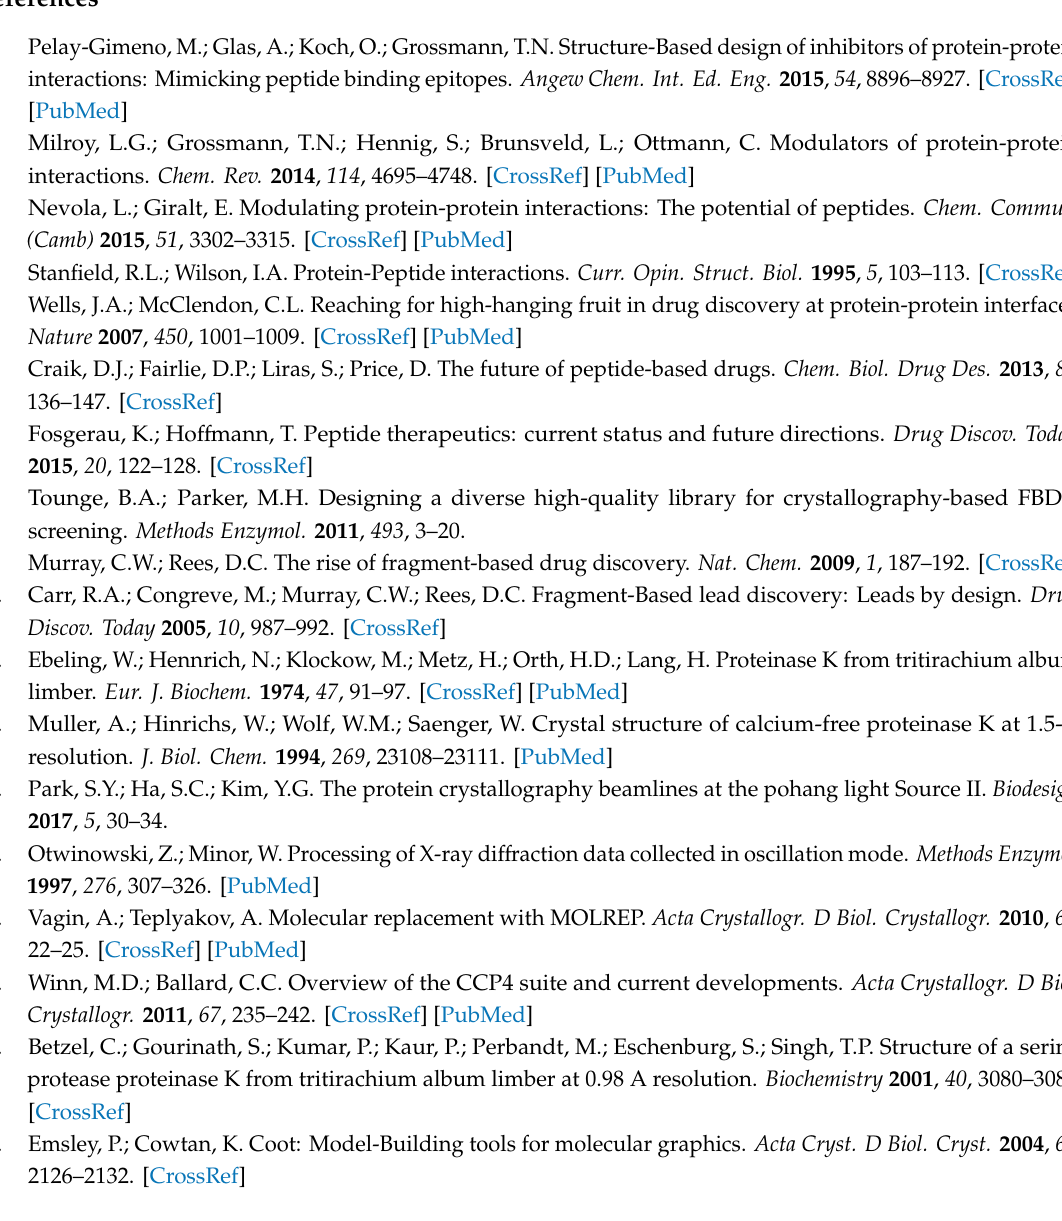
Figure S1: 2Fo-Fc electron density map (blue, counted 1.5 σ ) and Fo-Fc electron density map (green, counted 3 σ ; red, counted -3 σ ) of proteinase K complexd with triglycine (cyan). Figure S2: Comparison of substrate binding site of PaProK complexed with (a) triglycine or peptide based inhibitors from (b) PaProK-1P7V, (c) PaProK-1P7W, (d) PaProK-1PEK, (e) PaProK-1PFG, and (f) PaProK-3PPK. The transparent box in orange indicates the substrate binding